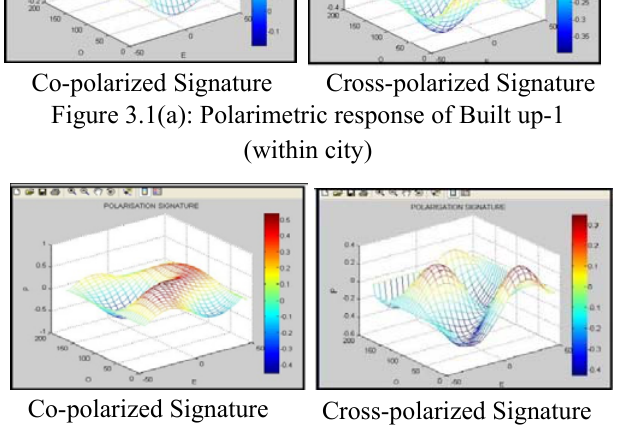
Figure 3.1(b): Polarimetric response of Built up-2 (within city)